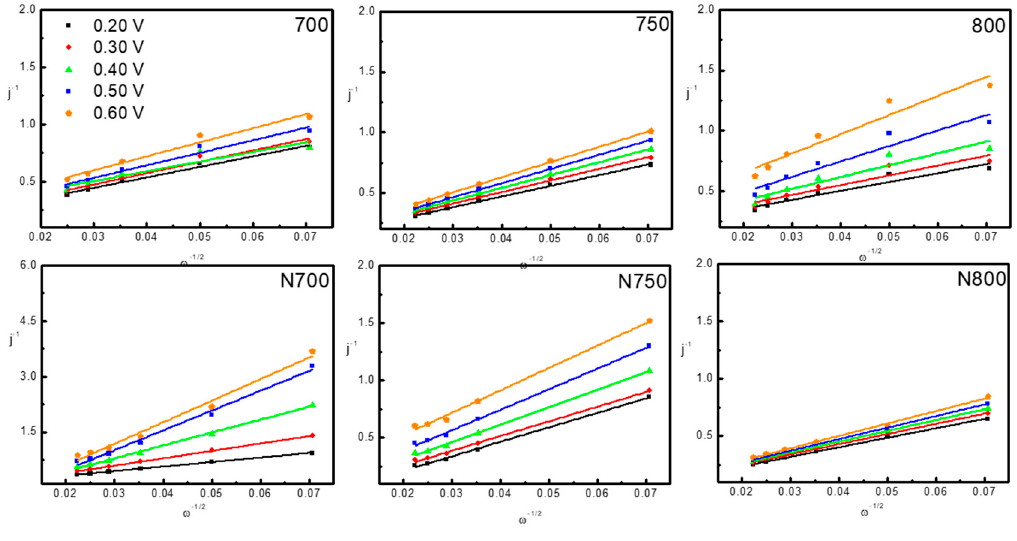
Figure 7. K-L plots of J − 1 vs. ω − 1/2 obtained from electrocatalysts (through Linear sweep voltammetry). Based on the K-L plot slopes and the intercepts obtained from 0.2 to 0.6 V vs. RHE (V vs. RHE),